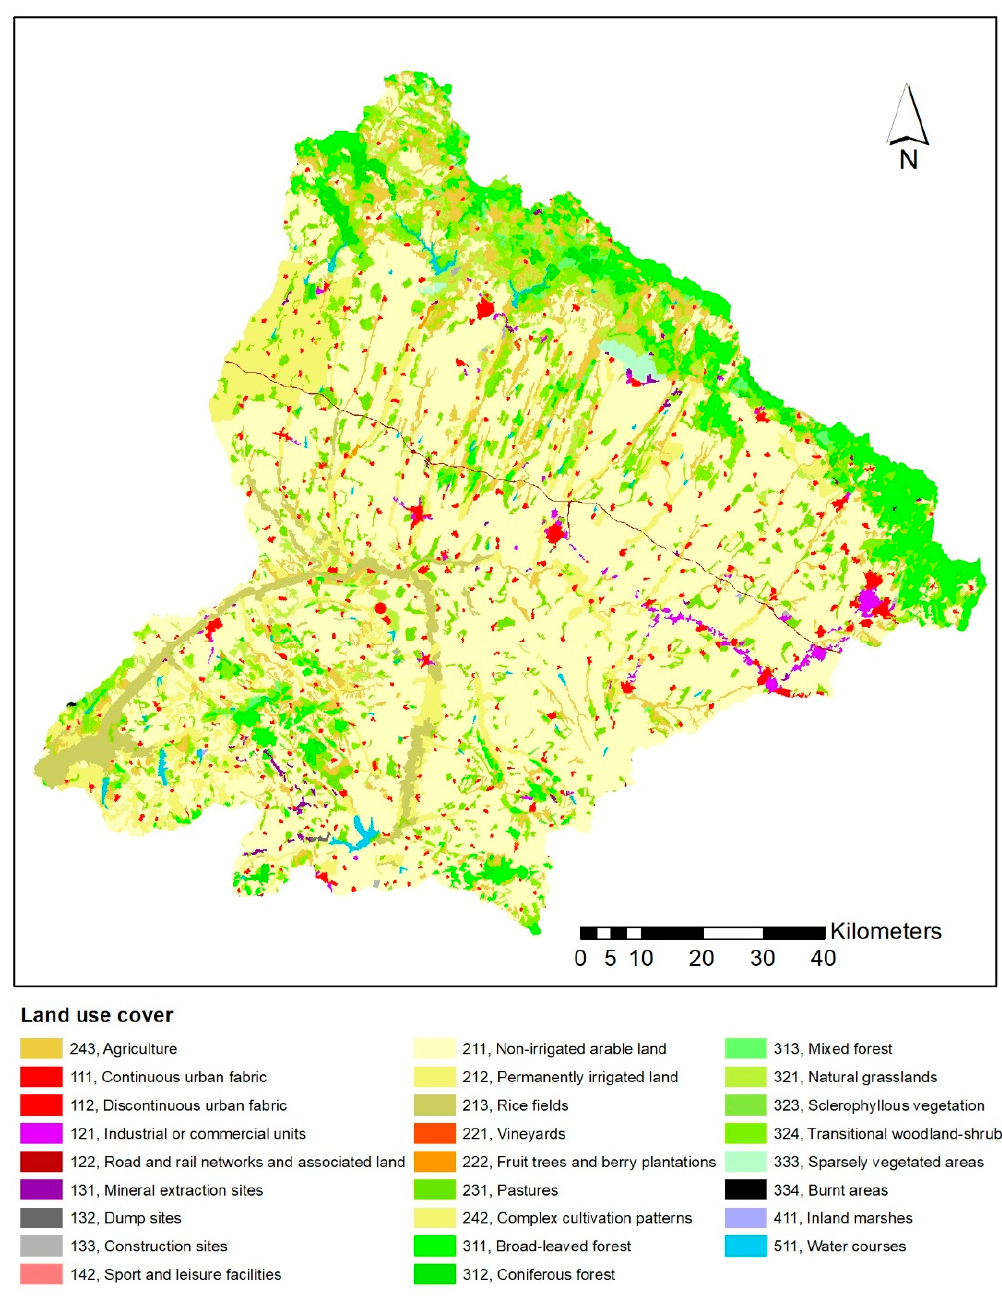
Figure 4. Land use types of the Ergene River catchment for the year 2012.